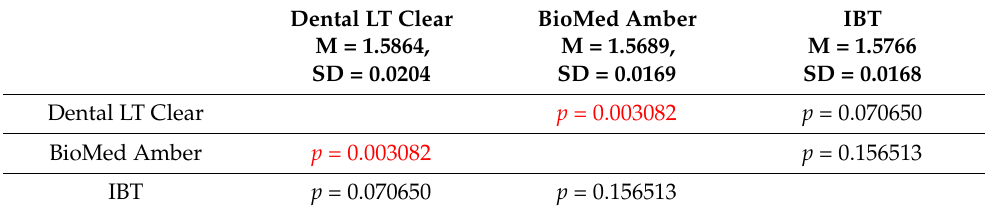
Table 11. Post hoc ANOVA results (least significant difference) for comparing FD values of each material before the compression test (M—mean; SD—standard deviation; p — p -value; the statistical significance for p < 0.05 was presented in red).